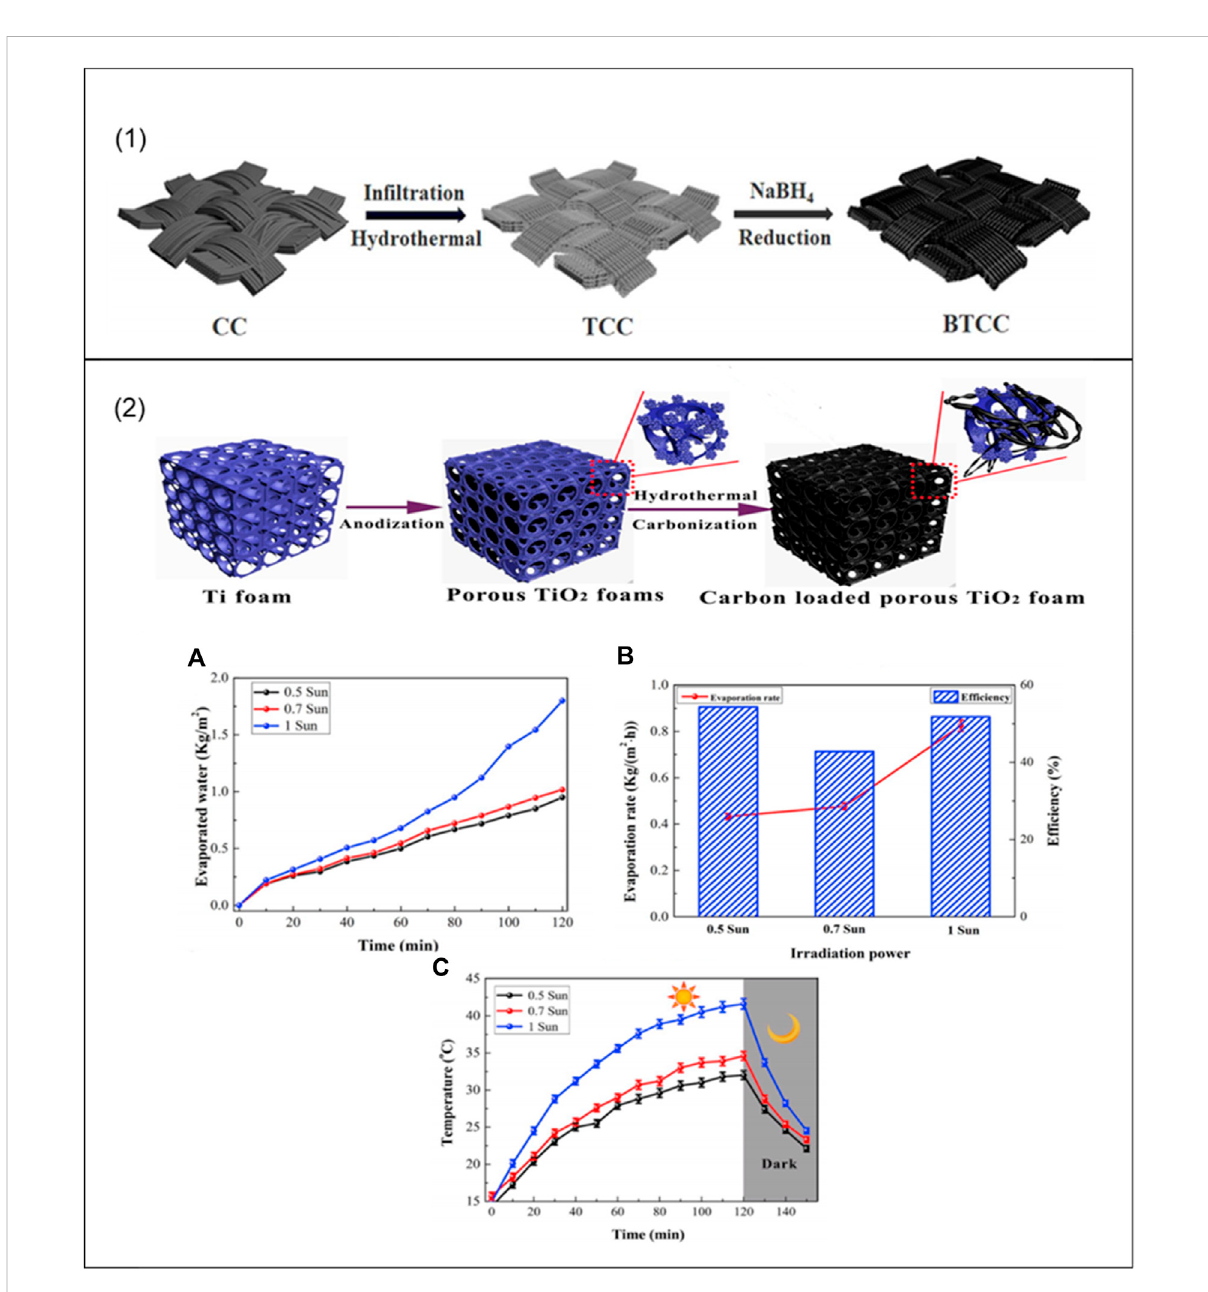
FIGURE 8 (1)DemonstrationofthepreparationofaBTCCnanocomposite(LiuandCheng,2018);Reproducedwithpermission.